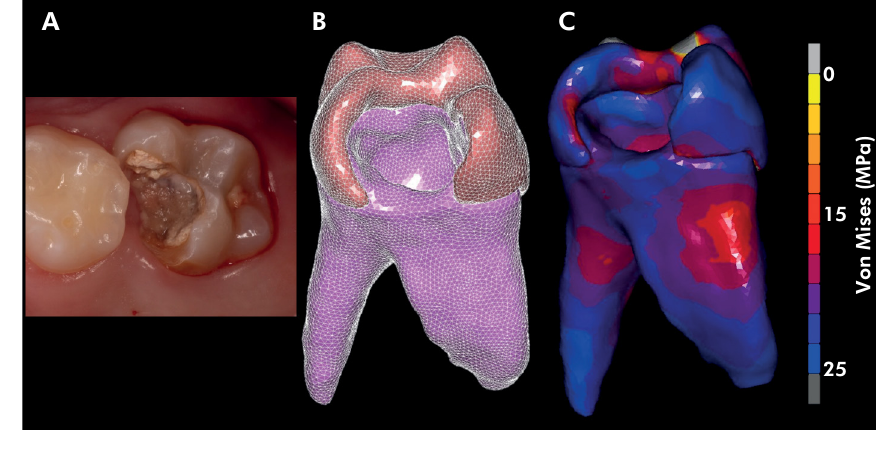
Figure 2. A. Clinical pictures of caries affected molar tooth; B. corresponding patient-specific finite element models. C. Modified von Mises stress concentration on occlusal enamel without dentin support and also on the pulp